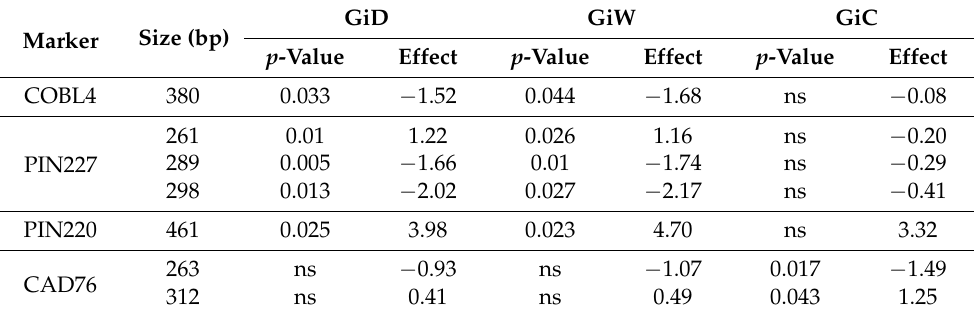
Table 2. Allelic effect on girth growth traits of each significant ILP marker in rubber tree breeding lines.